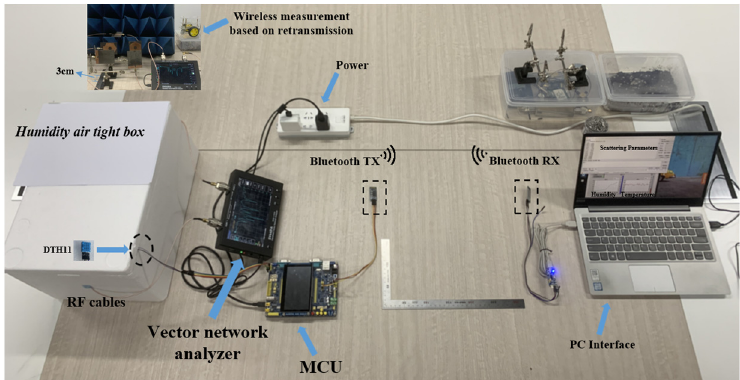
Figure 16. RFID tag dynamic spectrum monitoring and data wireless transmission experiment.